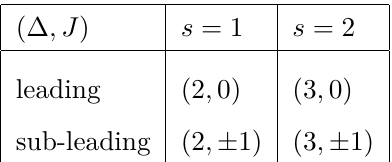
Table 2. (∆ , J ) of the soft operators O soft defined in table